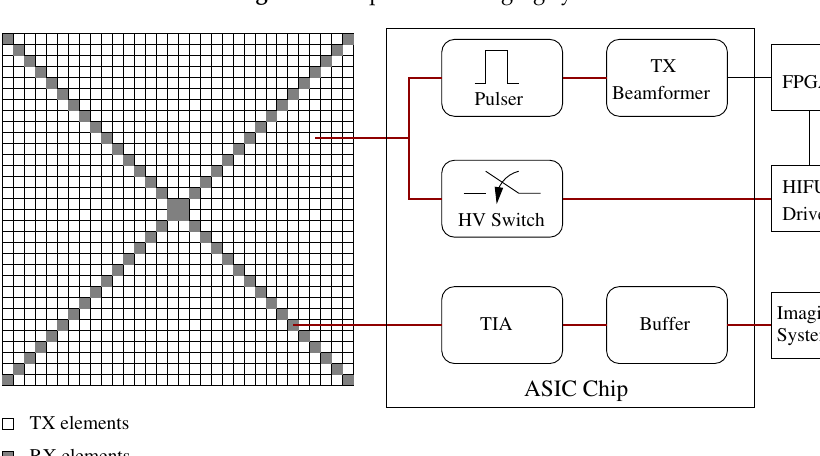
Figure 13. Capsule US imaging system.